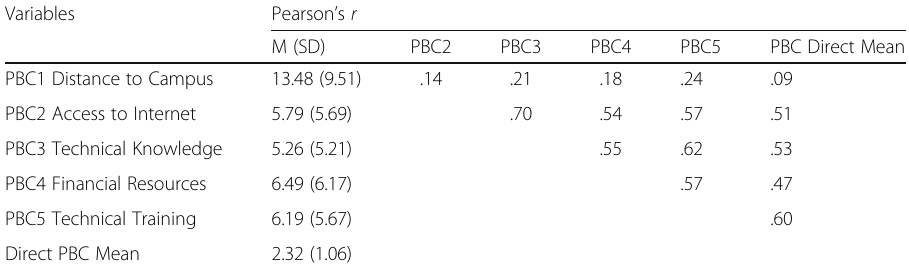
Table 2 Descriptive Statistics and Correlations of PBC Measures for the OLL Group (n = 289)